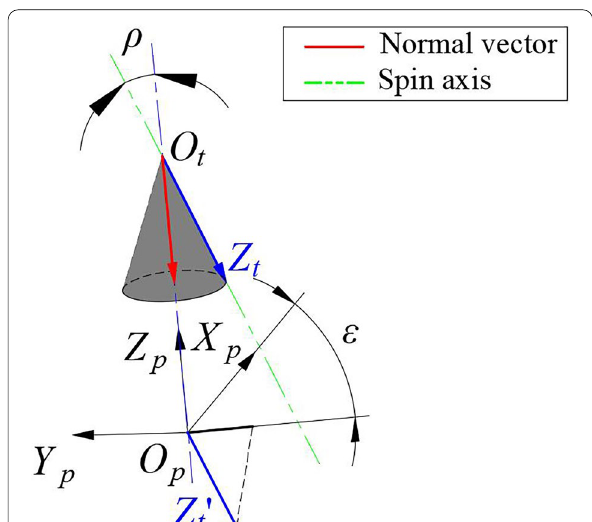
Figure 2 Schematic of spin axis distribution of